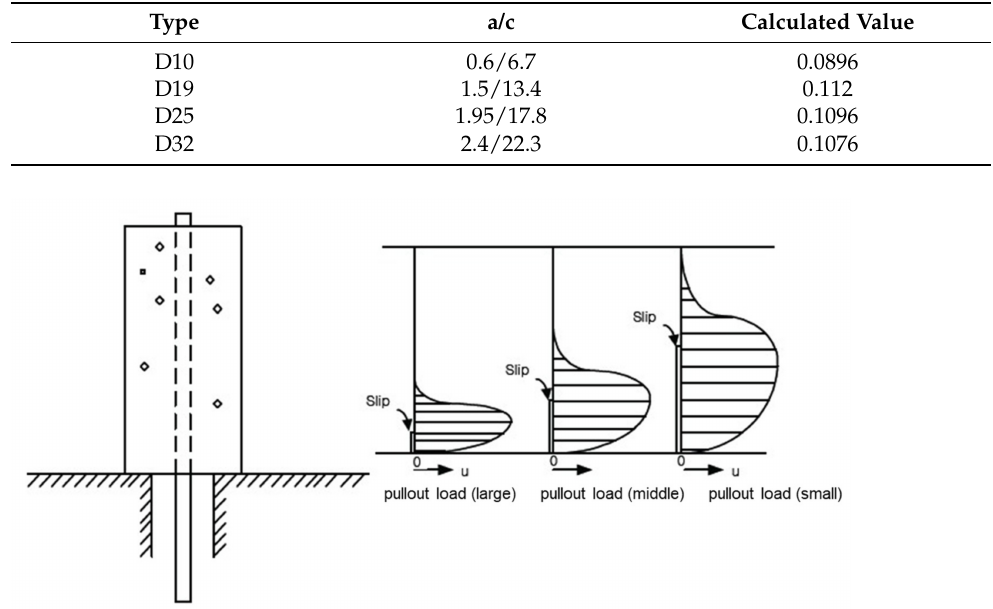
Table 6. Calculation of fracture aspects of deformed reinforcing bars by ribs.